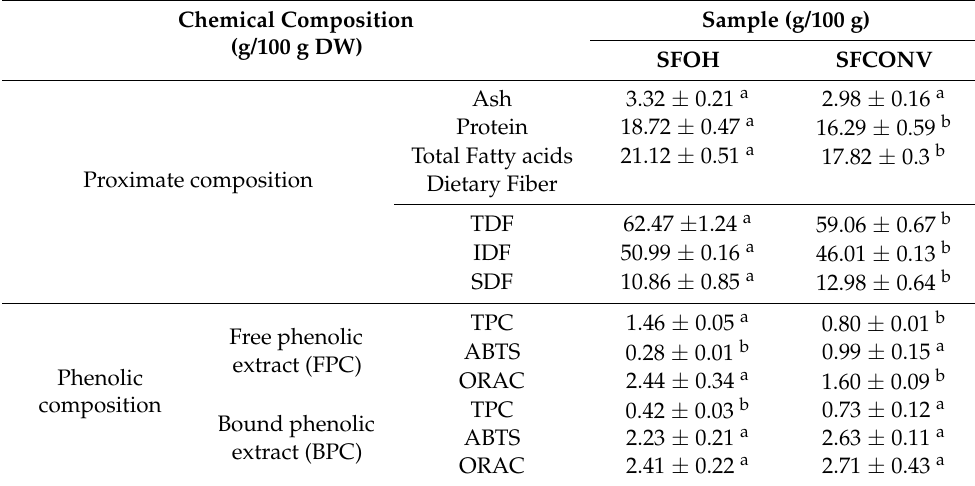
Table 1. The proximate composition, total phenolic compounds, and total antioxidant activity of SFOH and SFCONV (g/100g